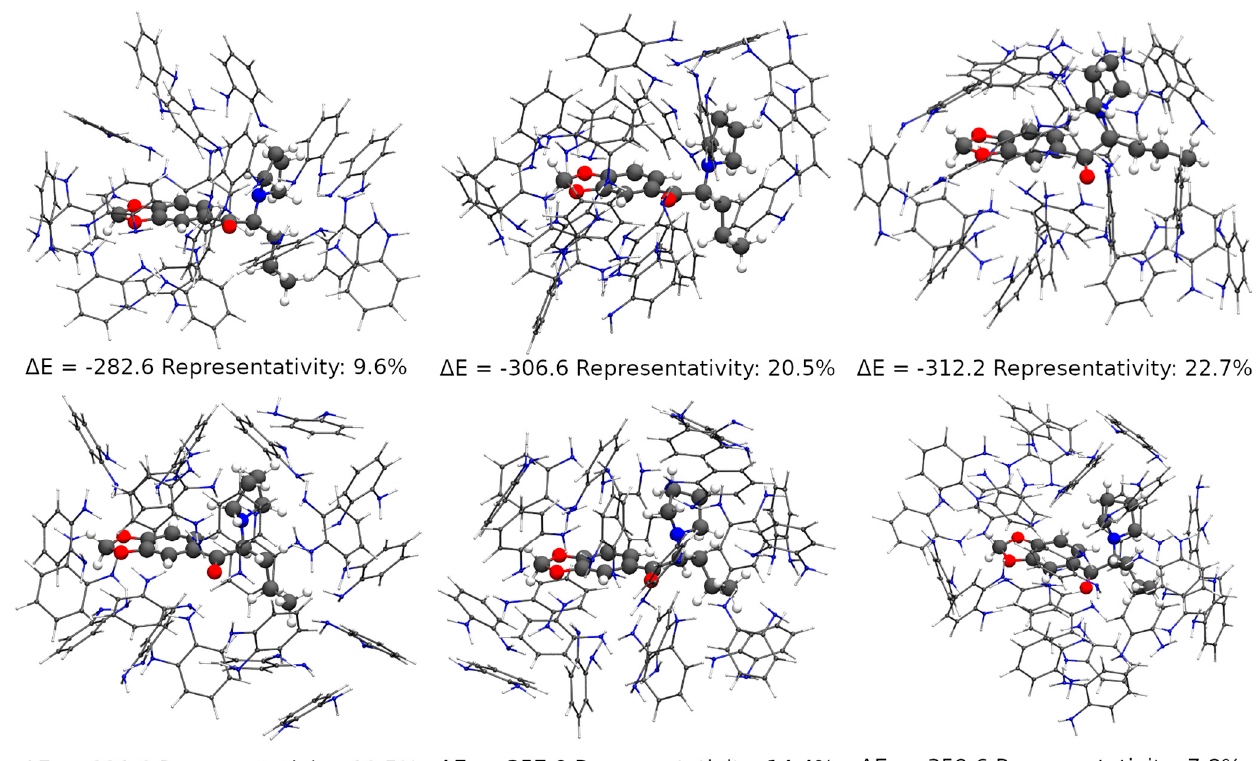
Figure 4. Most representative and stable cavities formed by o -PD monomers around MDPV. Energies in kcal mol − 1 .